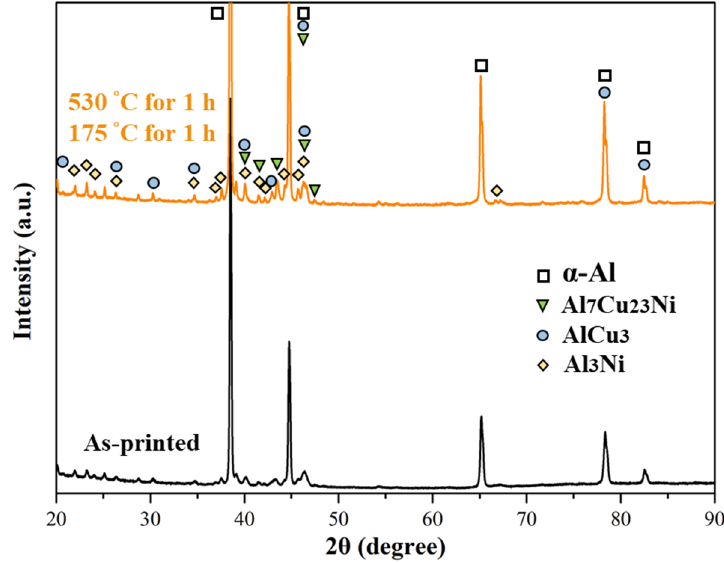
Figure 4. XRD pattern of the Al-Ni-Cu alloy before and after solution treatment.